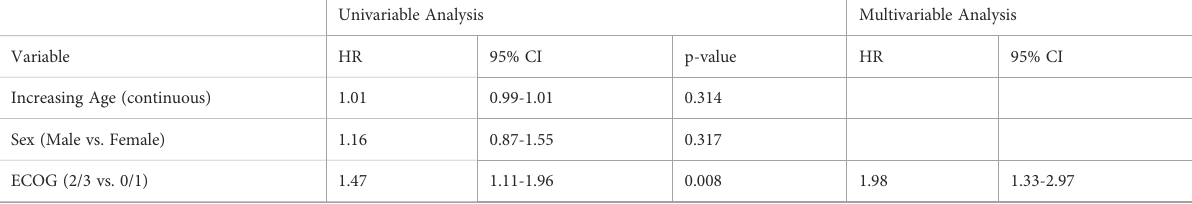
TABLE 3B Univariable and cox regression multivariable analyses for